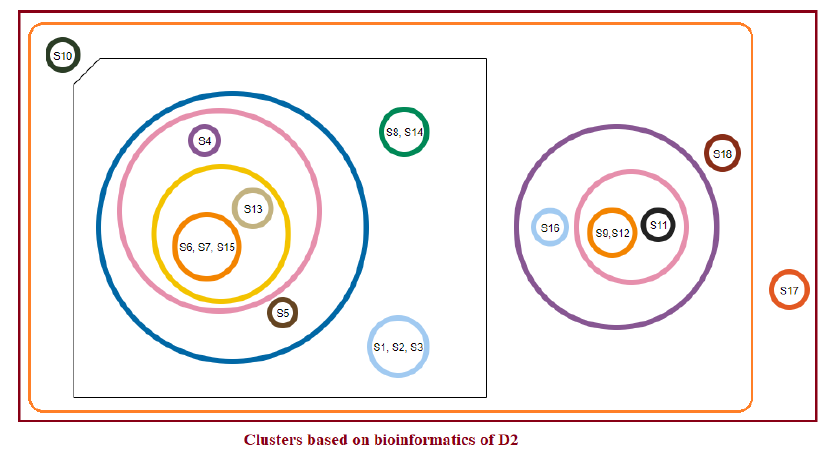
Figure 8. Distance matrix based on the bioinformatics feature vectors of D2 of ACE2 across eighteen species and associated clusters.